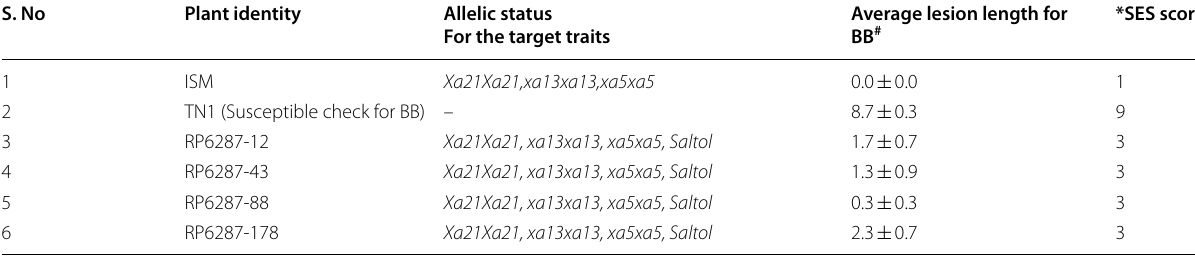
*SES—Standard Evaluation System; # All the introgression lines exhibited bacterial blight resistance with DRR isolate DX0-20